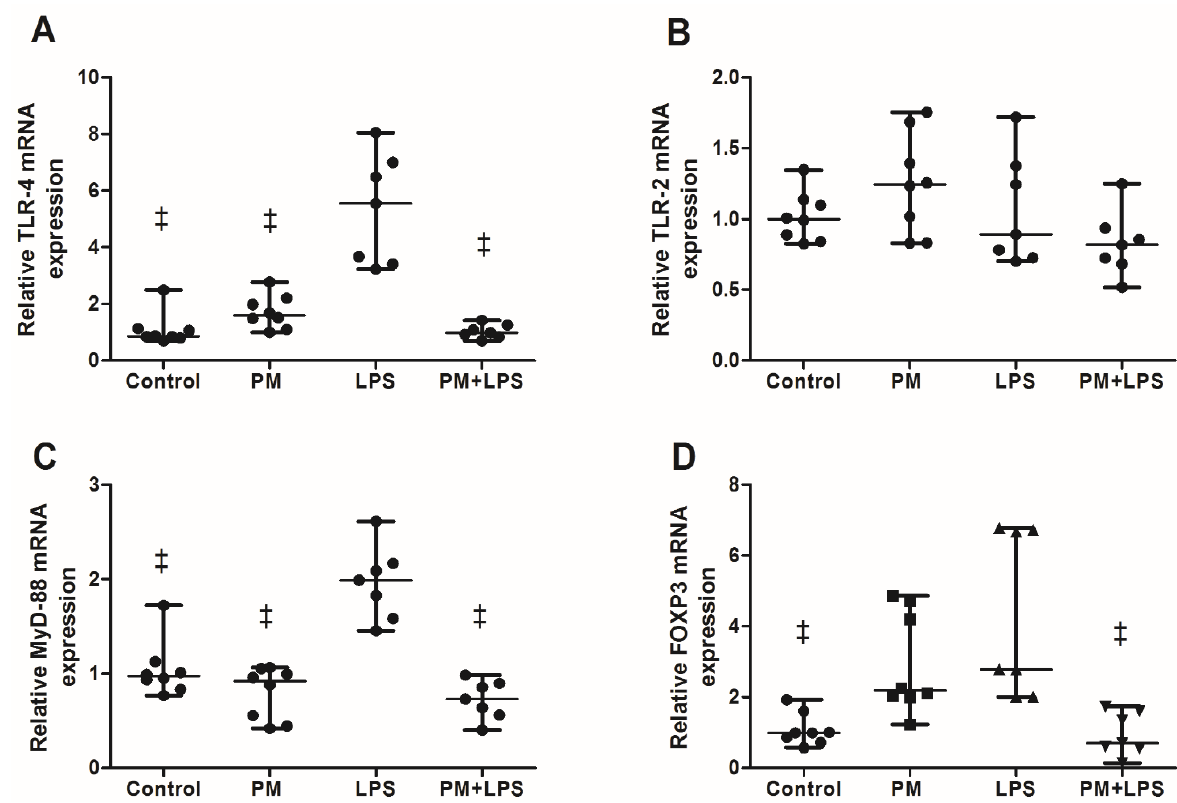
Figure 3. Graphical representation of ( A ) relative TLR-4 mRNA expression, ( B ) relative TLR-2 mRNA expression, ( C ) relative MyD-88 mRNA expression, and ( D ) relative FOXP3 mRNA expression assessed in the lung tissue. Each point represents one animal and bars show the median. ‡ p < 0.05 compared to the LPS group. Table 2. Inflammatory